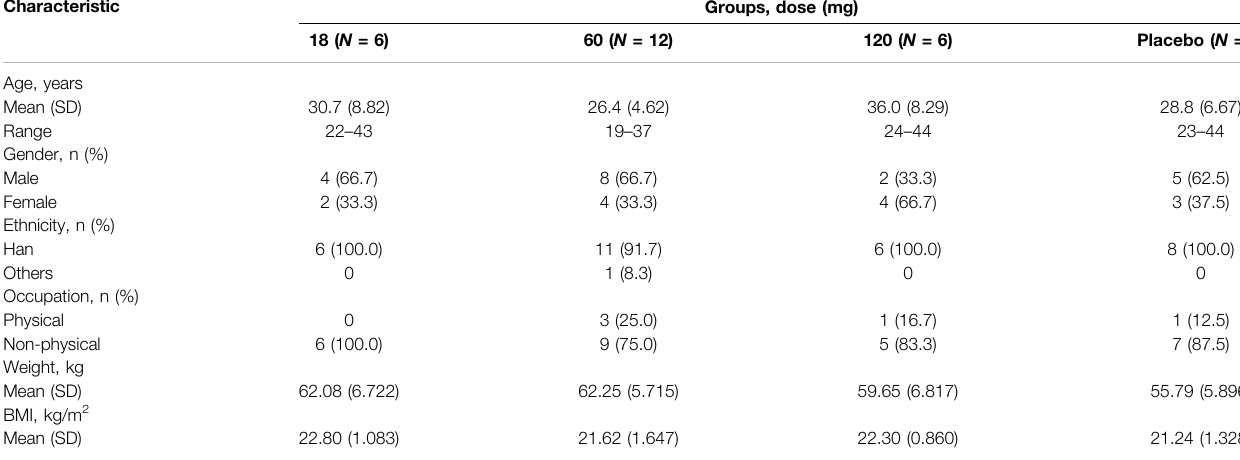
TABLE 1 | Demographic characteristics of the